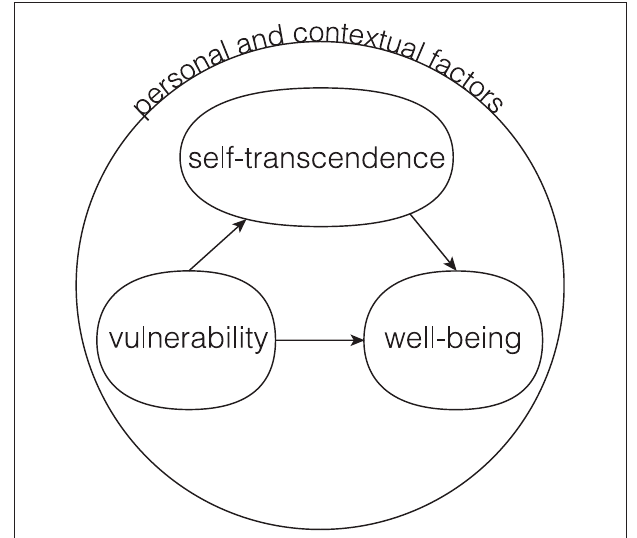
FIGURE 1 | Model of Self-transcendence in the context of nursing described in Reed